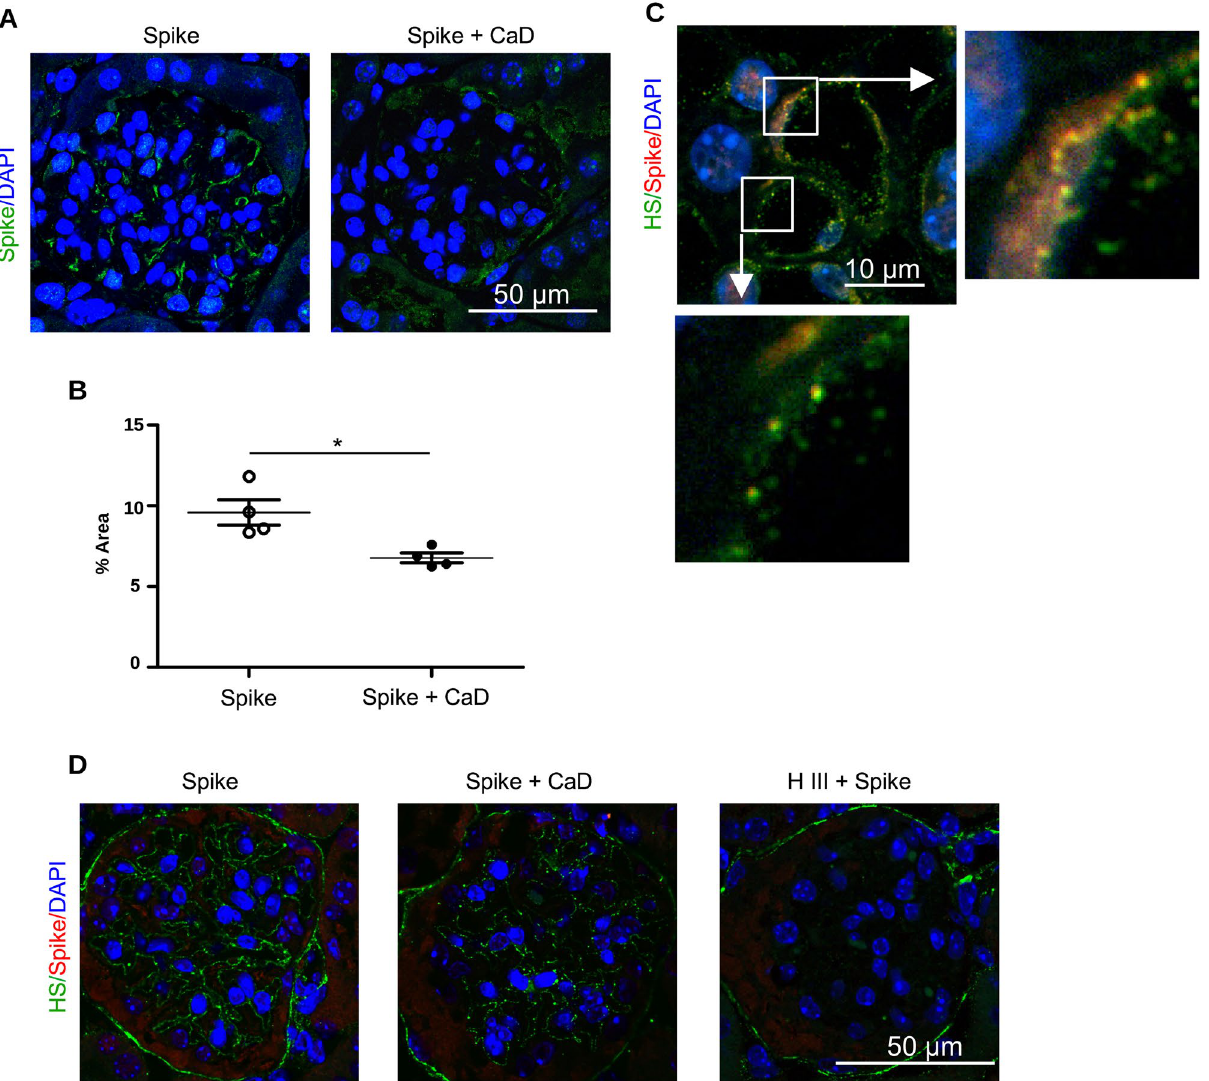
Figure 8. HS is essential for the retention of SARS-CoV-2 spike protein in ex vivo perfused mouse kidney. ( A ) Ex vivo perfused mouse kidney was stained using anti-spike protein antibody. Kidney glomerulus is shown. ( B ) Quantification of spike protein binding in kidney glomeruli using ImageJ software. ( C ) Peritubular capillary of the mouse kidney perfused with spike protein stained for HS (green), spike protein (red) and DAPI (blue). ( D ) Mouse kidney were perfused with spike protein pseudotyped lentivirus without or with 100 µM CaD. Kidney shown in right panel was perfused with heparinase III for 30 min prior the perfusion with spike